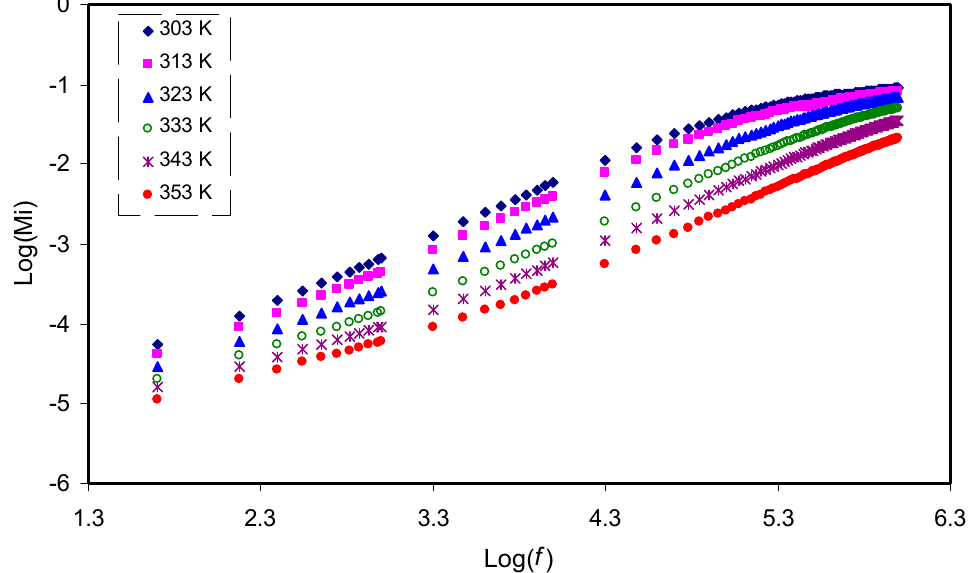
Figure 8. Frequency dependence of the imaginary part (M i ) of M* for the CS: POZ: MgTf systemat different temperatures.